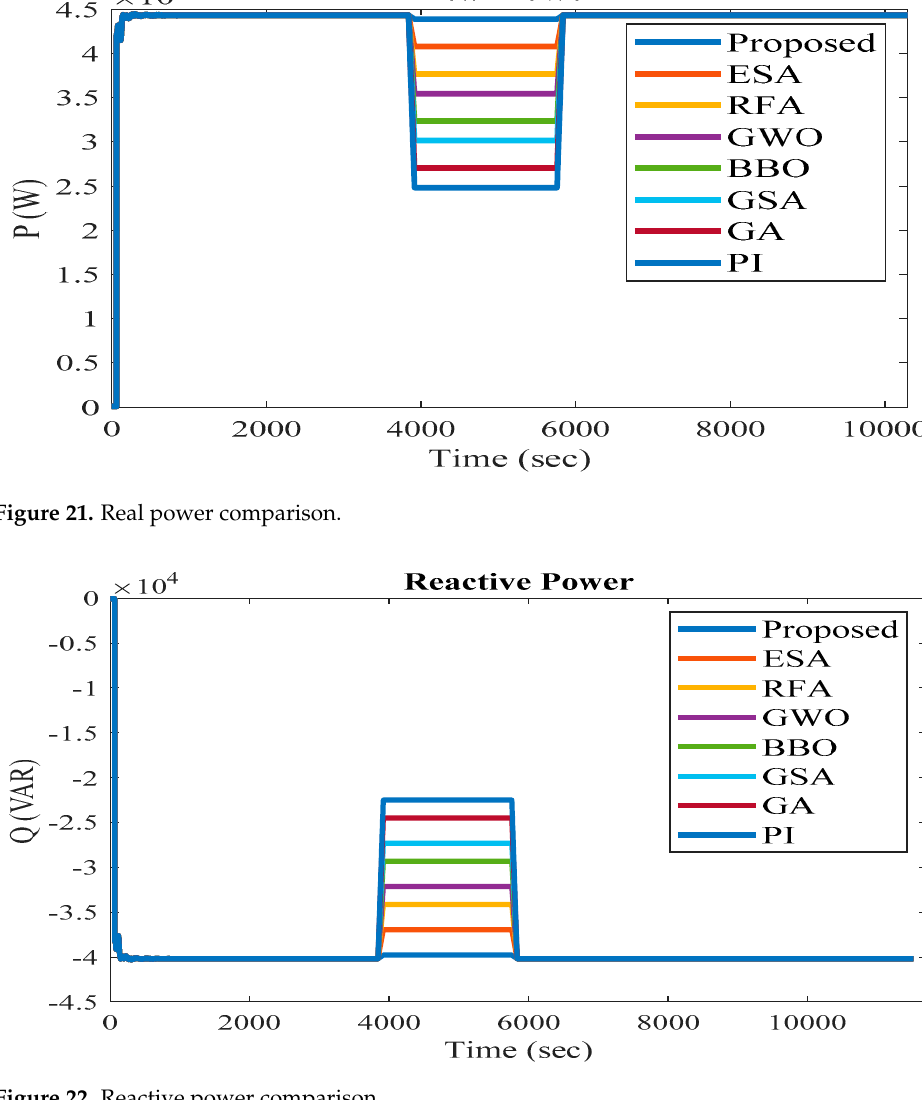
Figure 22. Reactive power comparison. Table 3. THD comparison before and after UPQC.